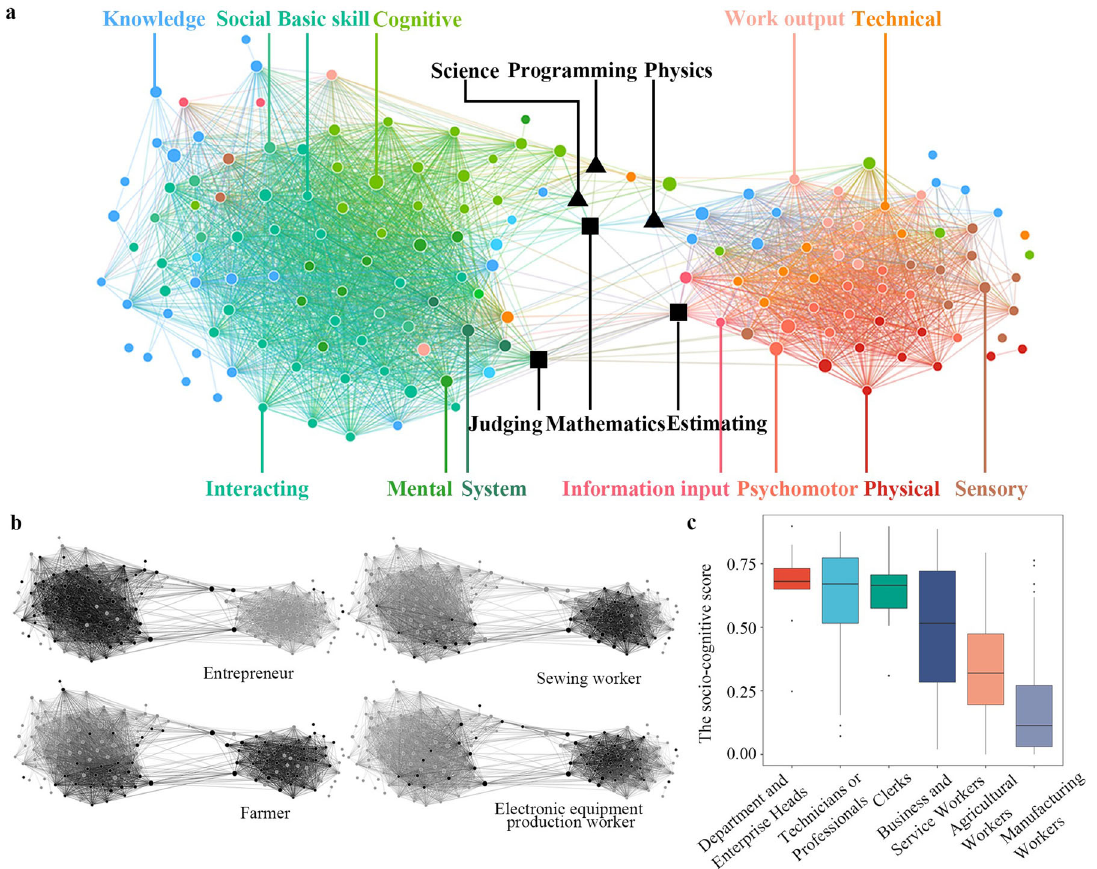
Fig. 4 China ’ s workforce skill space. a A skill space addresses the relationships between skill pairs. The edges represent skill-pair proximities that are the minimum probability of the corresponding pair co-occurring in the same occupation. Node colors represent the skill categories de fi ned by O*NET and node sizes re fl ect the betweenness centrality. We name the cluster on the left “ socio-cognitive ” skill cluster and the right “ sensory-physical ” skill cluster, given the types of skills that constitute them. Three skills Judging the Quality of Things, Mathematics , and Estimating the Quanti fi able Characteristics of Product, Event or Information , are highlighted in black squares, as they have the greatest betweenness centrality in the network indicating their transition positions between the two clusters. Mathematics is a complementary skill to Science, Physics and Programming which are highlighted in the black triangles. b Four occupations ’ positions in the skill space. The darker nodes the more important those skills to the corresponding occupations. c The socio-cognitive scores of 6 major occupation groups. Department and Enterprise Heads and Technicians and Professionals have greater socio-cognitive scores than the other occupation